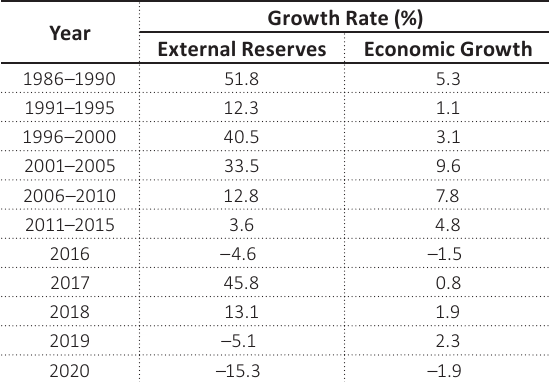
Table 1. Structure of external reserves and economic growth in Nigeria